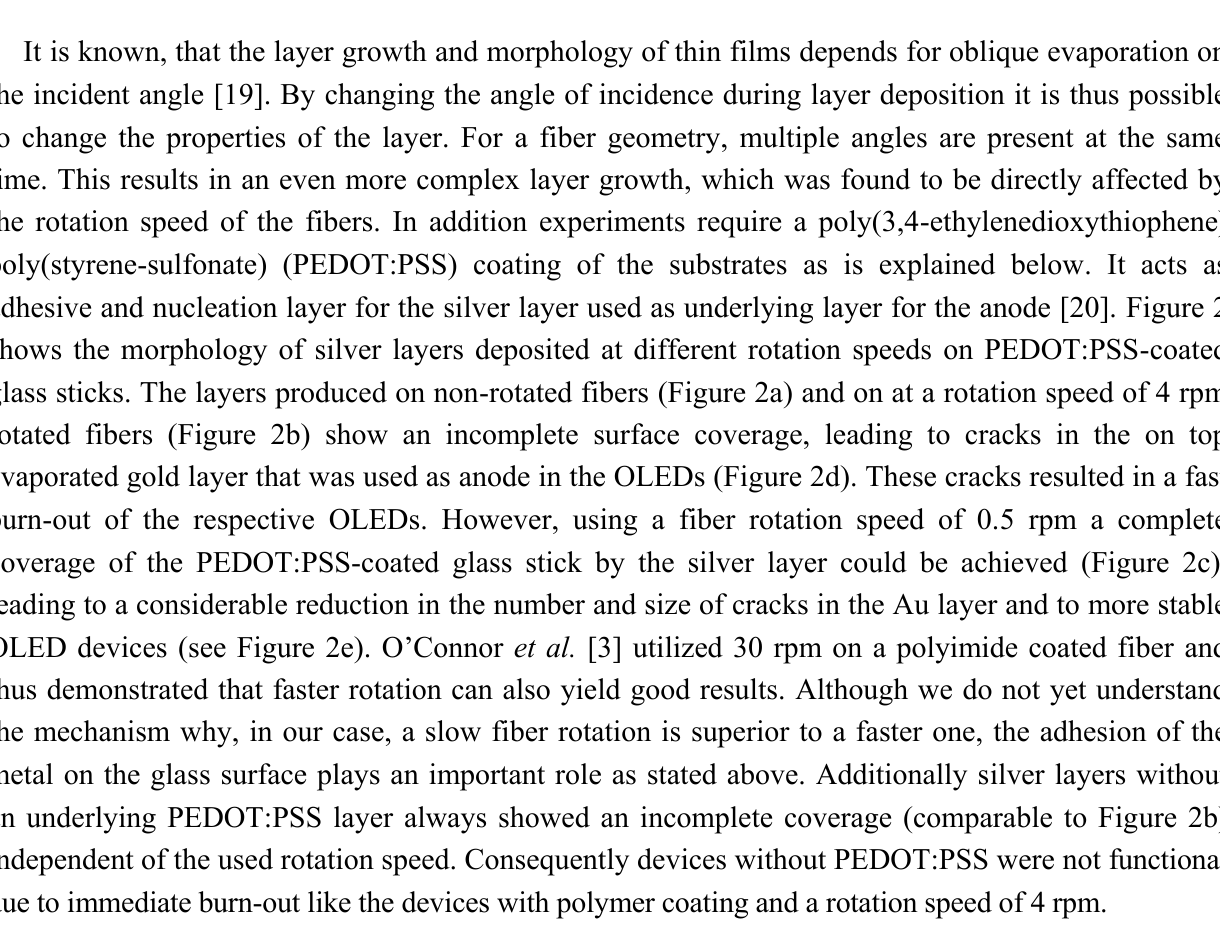
Figure 2. Scanning electron microscope images of Ag and Au surfaces. All layers were deposited with varying rotation speeds onto glass sticks (diameter 1 mm) coated with 110 nm PEDOT:PSS. ( a ) 20 nm Ag (no rotation); ( b ) 20 nm Ag (4 rpm); ( c ) 20 nm Ag (0.5 rpm); ( d ) 30 nm Au (4 rpm) on 20 nm Ag (4 rpm); ( e ) 30 nm Au (4 rpm) on 20 nm Ag (0.5